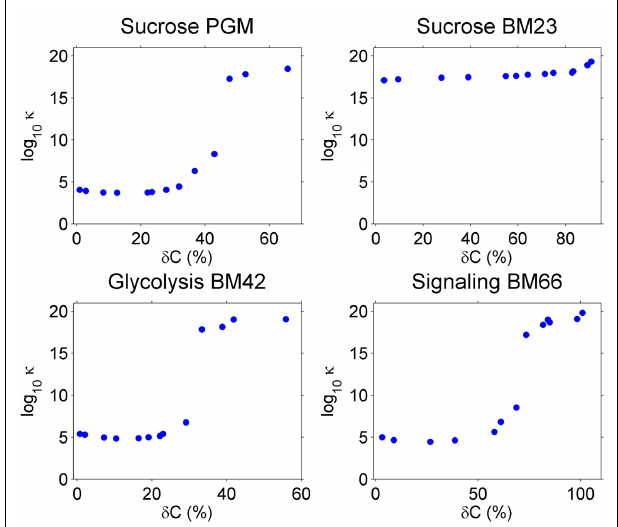
FIGURE 2 | The condition number κ A ( y -axis) increase with higher perturbation amplitude ( x -axis) on the covariance C . Note that y -axis is in log 10